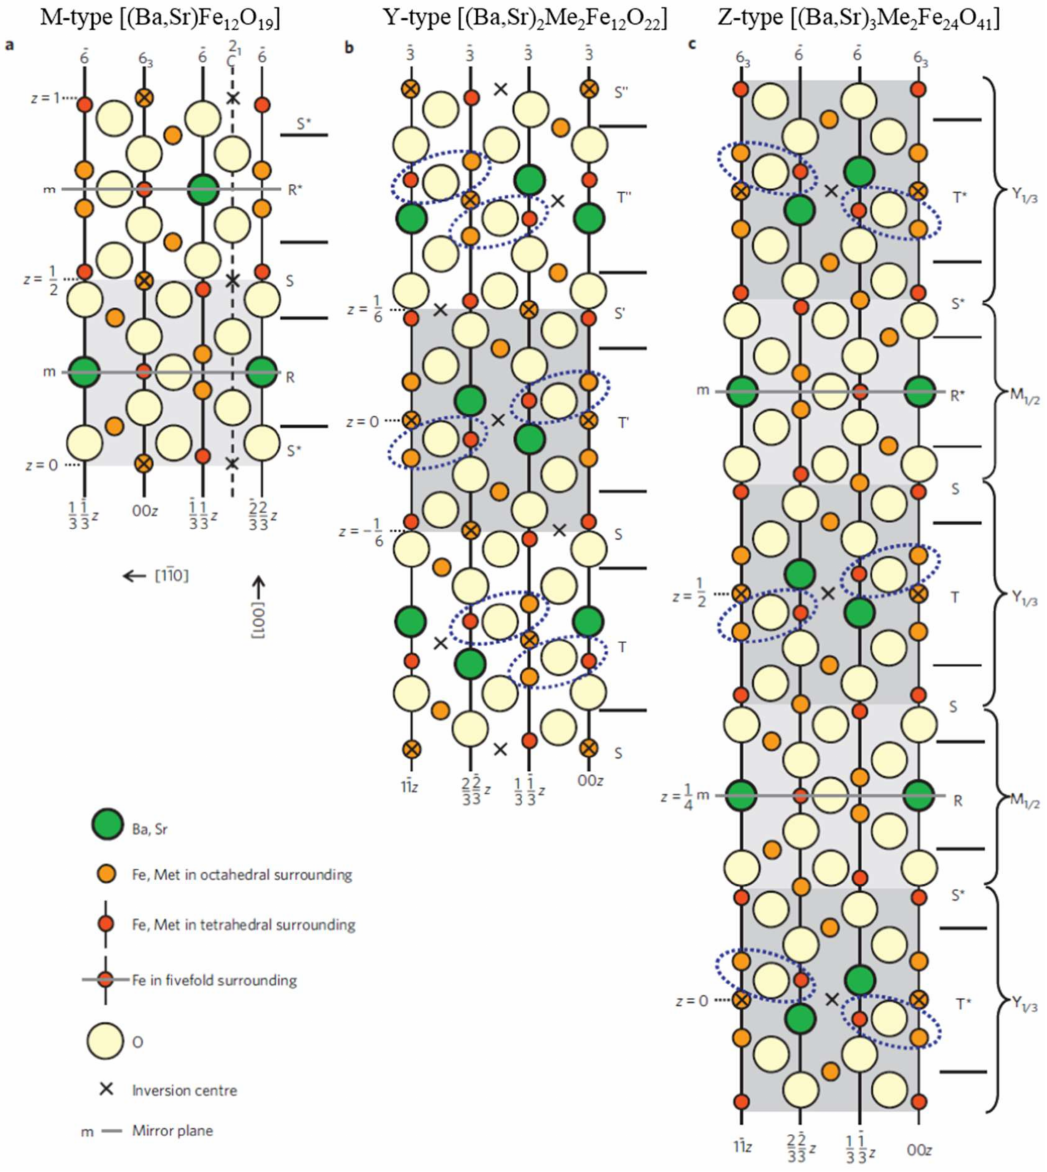
Figure 1. Structure of hexaferrites: left to right—M-type; Y-type; Z-type [15]. Reprinted by permission from Springer/Nature [Nature Materials]; low-field magnetoelectric effect at room temperature by Kitagawa et al., [Copyright]